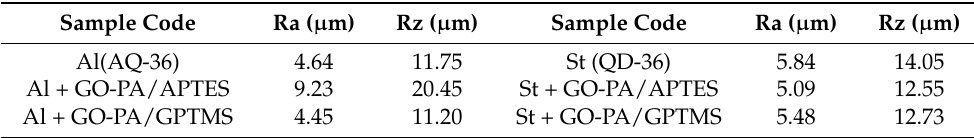
Figure 11. Surface roughness profiles of the different coatings deposited on aluminum ( a ) and steel ( b ). Table 2. Roughness profile values of the different Table 2. Roughness profile values of the different coatings.